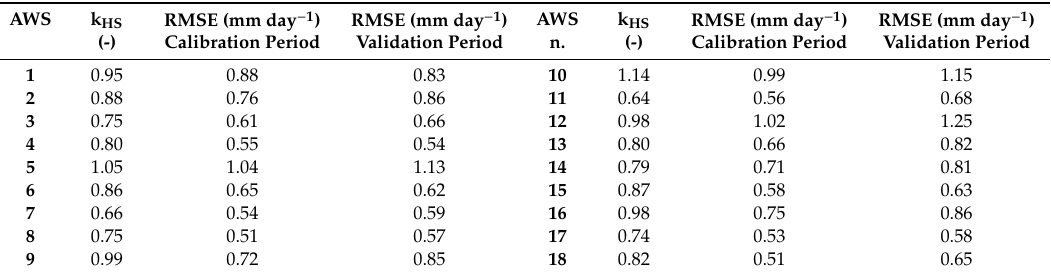
Table 2. Calibrated k HS values along with RMSE for the calibration (2010–2013) and validation